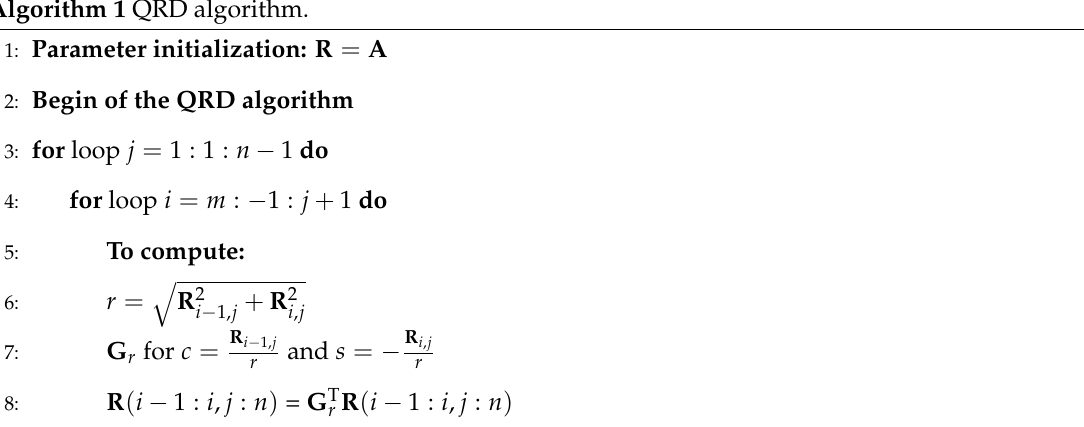
Algorithm 1 QRD